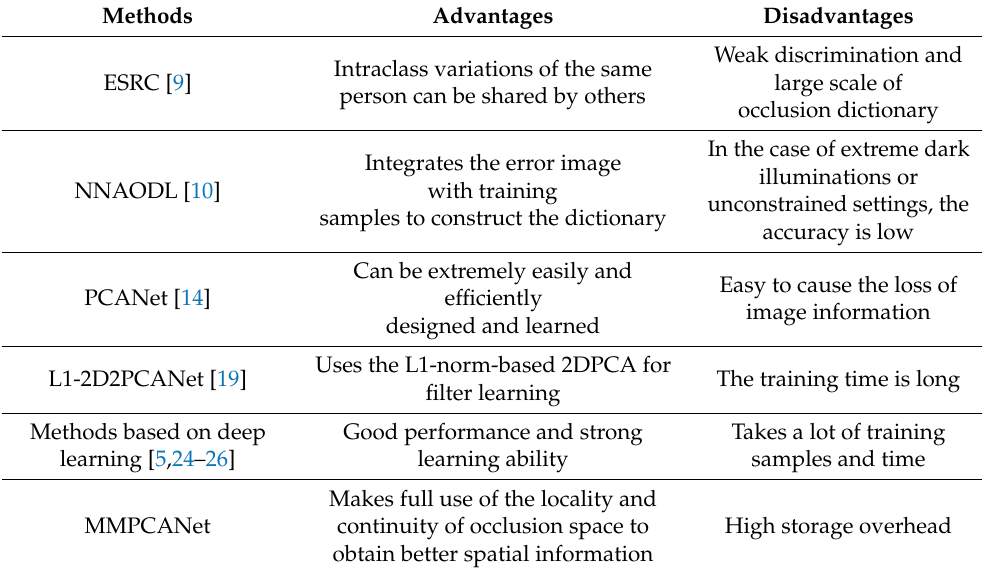
Table 1. Key differences between a number of previous methods and proposed methods. Methods Advantages Intraclass variations of the same ESRC [9] person can be shared by others Integrates the error image samples to construct the